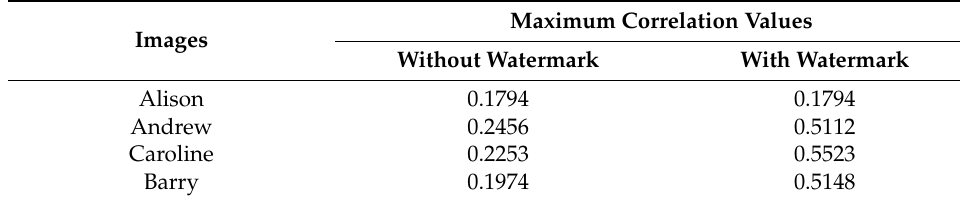
Figure 10. Set of tested images. Table 4. The correlation values of images after the print-cam process.